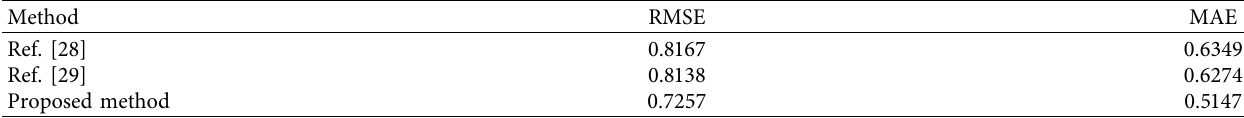
Table 3: Comparison of diferent methods under the Criteo dataset.